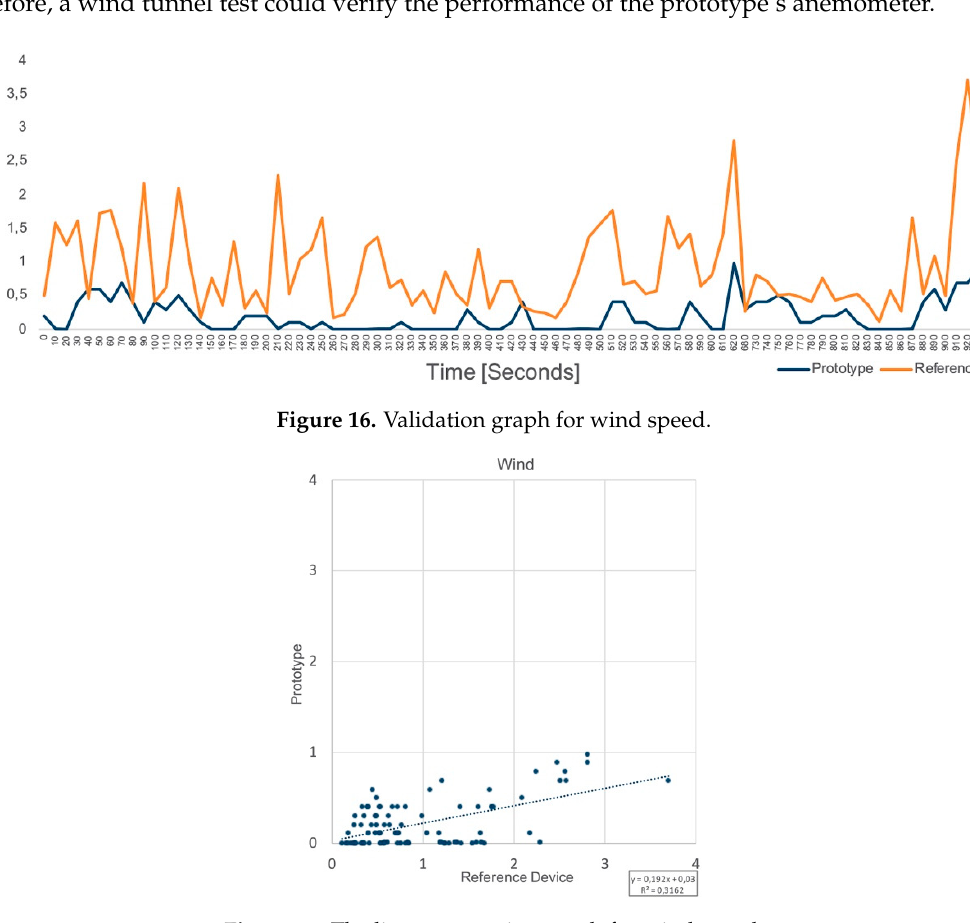
Figure 17. The linear regression graph for wind speed.